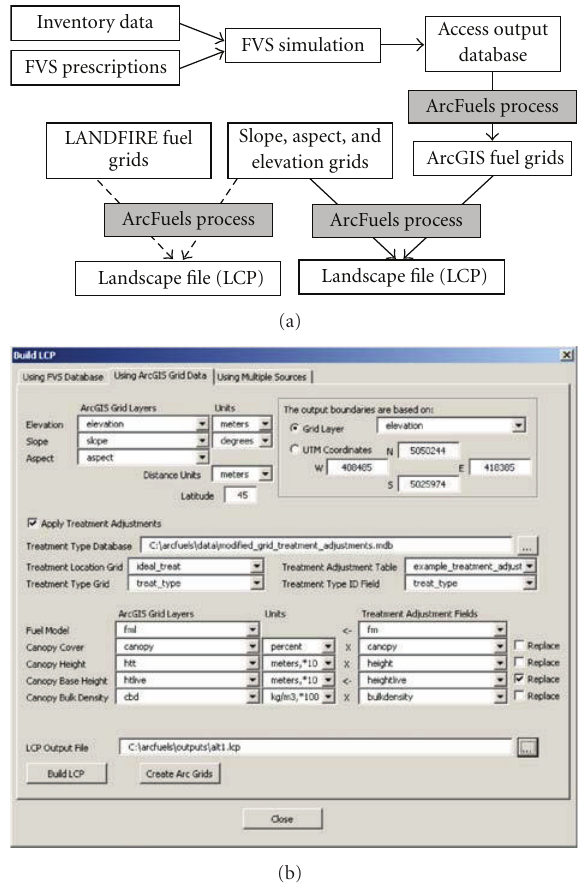
Figure 6: Flow chart (a) of process for creating binary landscape files for modeling fire behavior in FlamMap and FARSITE from inventory or LANDFIRE grid data for the Mt. Emily study area and the ArcFuels form (b) is used to convert the ArcGIS grids. Treatments are e ff ected using adjustment databases as described in the ArcFuels user’s guide. A separate form exists for processing outputs from FVS simulations or for using multiple sources of ArcGIS grid data. The form can be used to modify LANDFIRE grid data to reflect proposed fuel